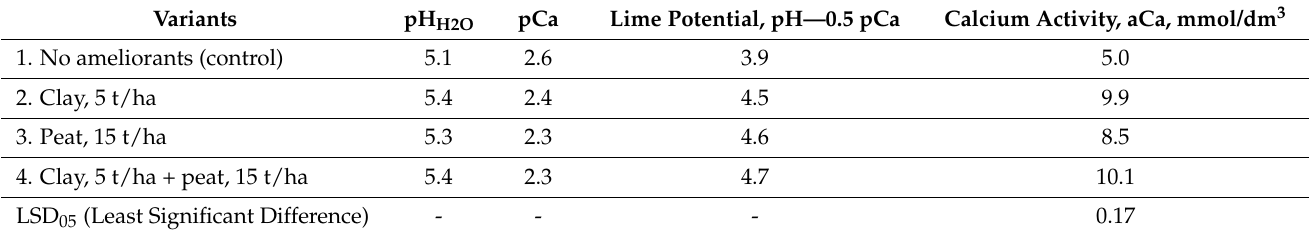
Table 1. Changes in physical and chemical parameters of sod-podzolic cohesive sandy gleyed soil under the influence of claying (laboratory model